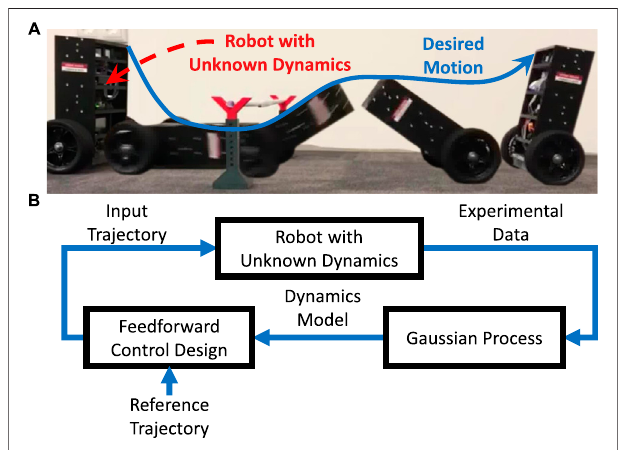
FIGURE 1 | (A) A robot with unknown dynamics is meant to track a reference trajectory leading to a desired, highly dynamic motion. (B) On each iteration, the proposed learning method determines, based on experimental data, a Gaussian Process model, which is in turn used to design and apply a feedforward control